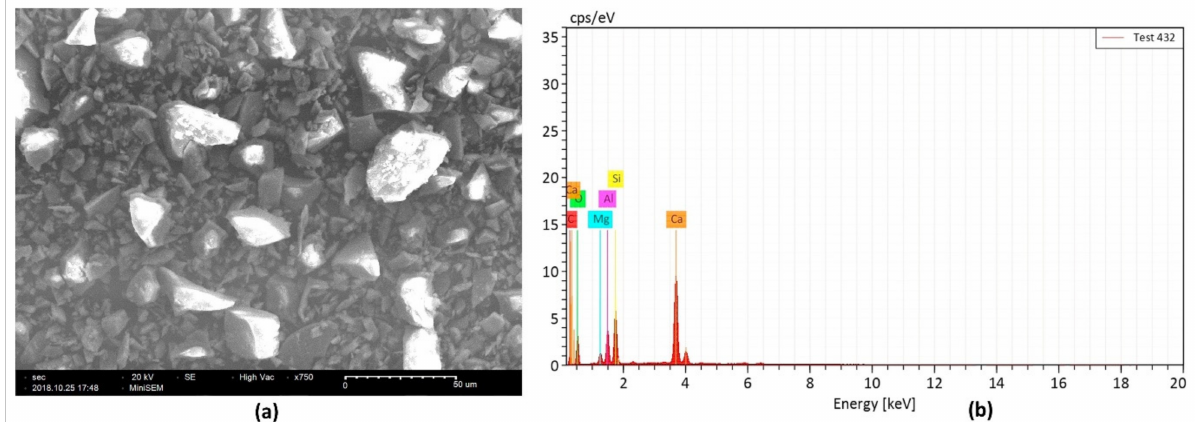
Figure 8. Results of ground granulated basalt furnace slag from ( a ) SEM analysis shows different grades of denser particles and ( b ) EDX analysis shows higher silicon content than OPC. Reprinted with permission from Ref. [74]. Copyright 2021, with permission from